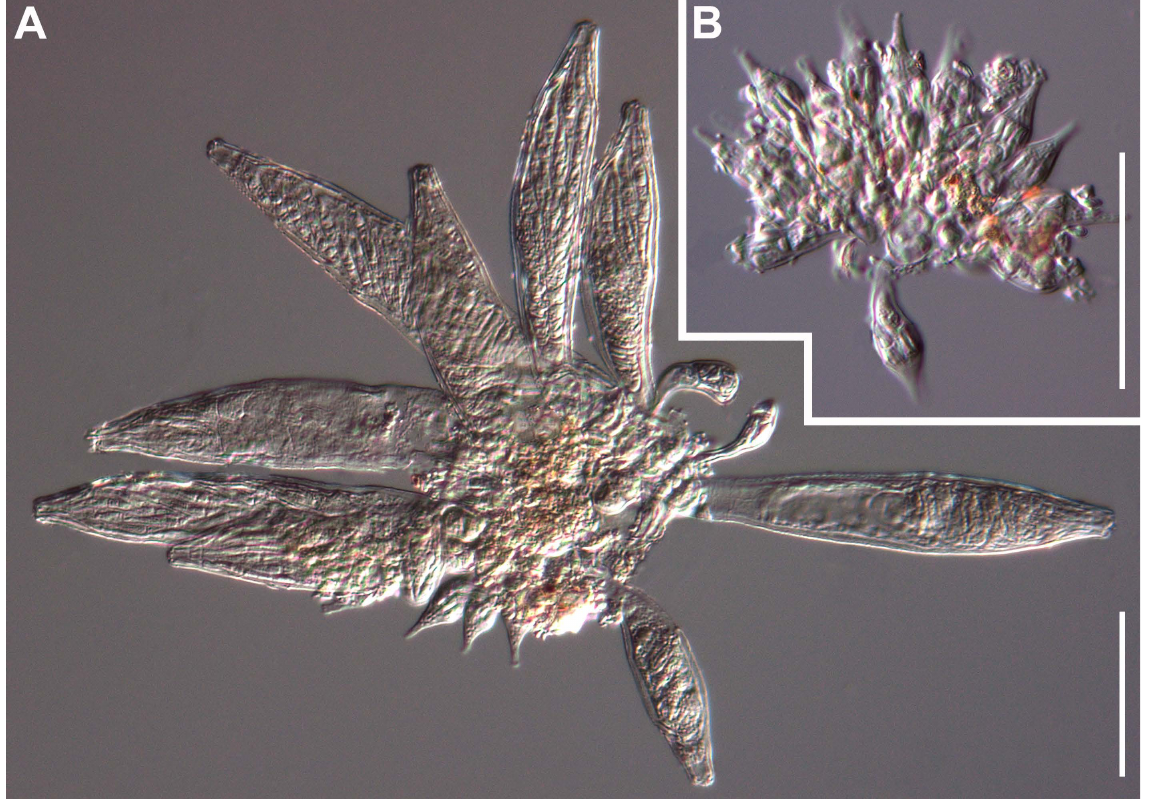
Fig. 74. Trenomyces histophthorus Chatton & F.Picard. A . Mature male and female thalli. B . One or more male thalli. Scale bars: 50 µm. Photographs from slides ZMUC C-F-124344 (A), ZMUC C-F-124345